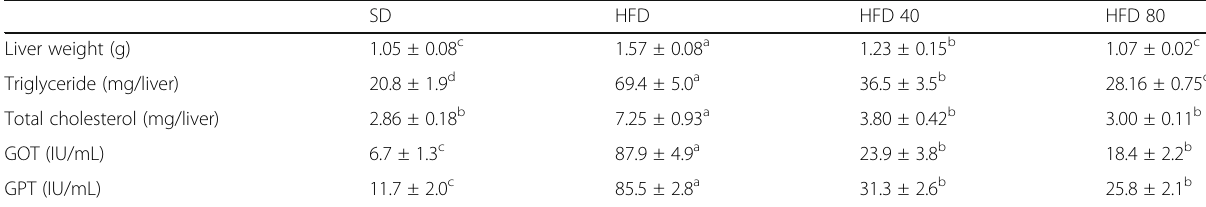
Table 4 Effect of purpurin on the liver